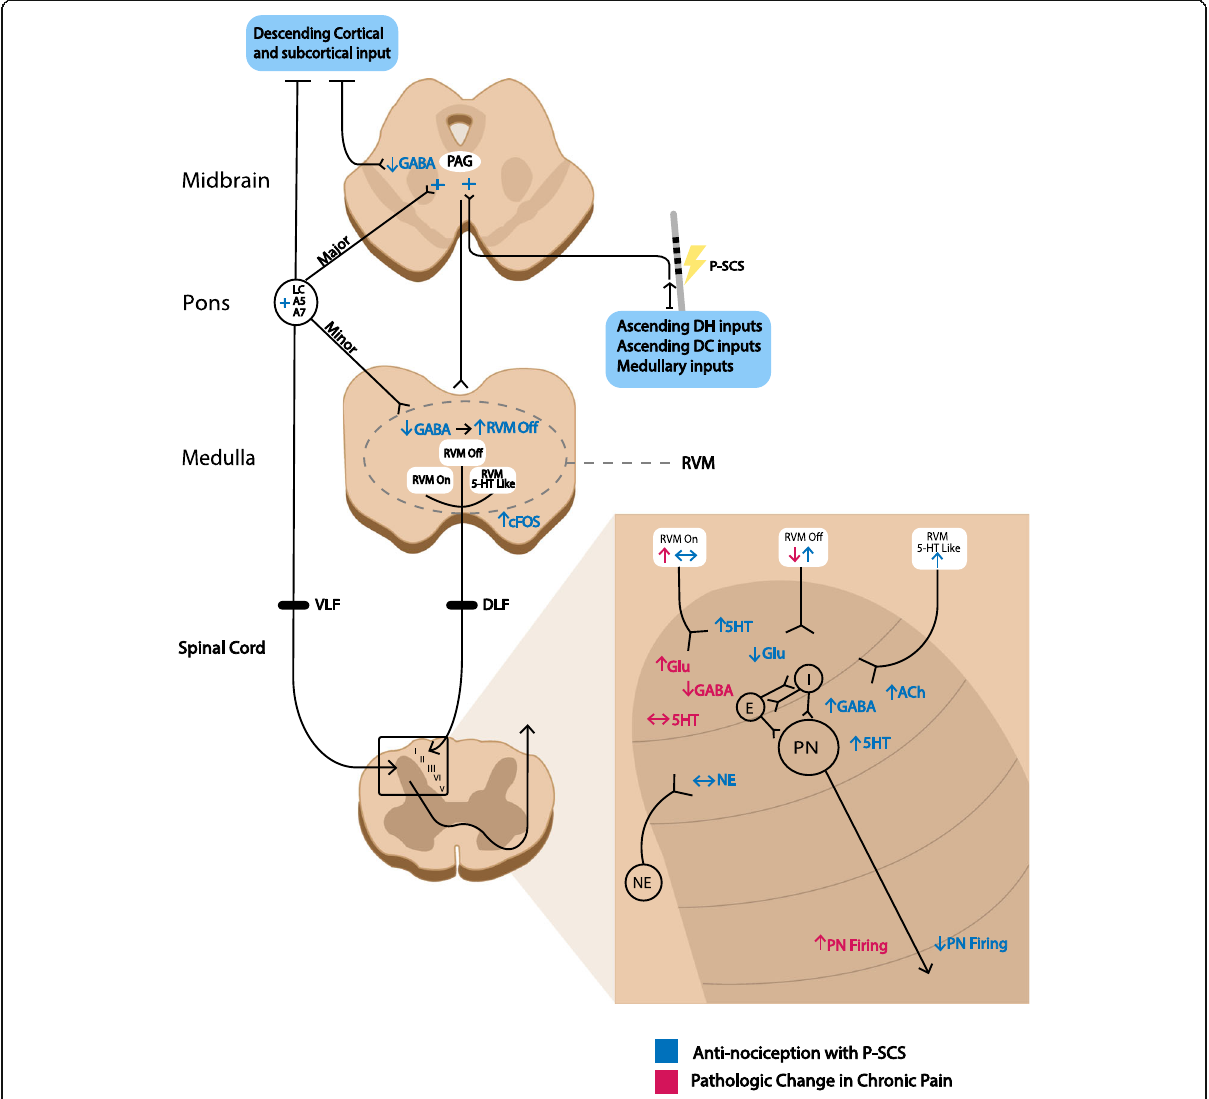
Fig. 5 Supraspinal Mechanisms of Spinal Cord Stimulation. A hallmark of chronic pain, abnormal enhancement of excitatory pathways and a loss of inhibition facilitate nociceptive transmission to sub-threshold stimuli. With SCS, orthodromic activation of supraspinal centers of pain control facilitates antinociception through activation of the DAS, largely through recruitment of the PAG, RVM and LC. Increases in spinal ACh, 5-HT and GABA as well as decreased spinal glutamate with SCS are in part thought to be a result of descending pathway recruitment. ‘ Up ’ arrows represent increased concentration or activity, whereas ‘ down ’ arrows represent opposite. ‘ Sideways ’ arrows represent no change. Acronyms: PAG (Periaqueductal Gray), RVM (Rostral Ventromedial Medulla), LC (Locus Coeruleus), A5 (Noradrenergic Cell Group A5), A7 (Noradrenergic Cell Group A7), DH (Dorsal Horn), DC (Dorsal Column), VLF (Ventrolateral Funiculus), DLF (Dorsolateral Funiculus), RVM ON (RVM On cells projecting from the RVM to the DH), RVM OFF (RVM OFF cells projecting from the RVM to the DH), RVM 5-HT Like (RVM 5-HT Like cells projecting from RVM to DH), cFOS (proto-oncogene), E (Excitatory Interneuron), I (Inhibitory Interneuron), PN (Projection Neuron), Glu (Glutamate), 5-HT (5-hydroxytryptamine), ACh (Acetylcholine), NE (Norepinephrine), GABA (Gamma Aminobutyric